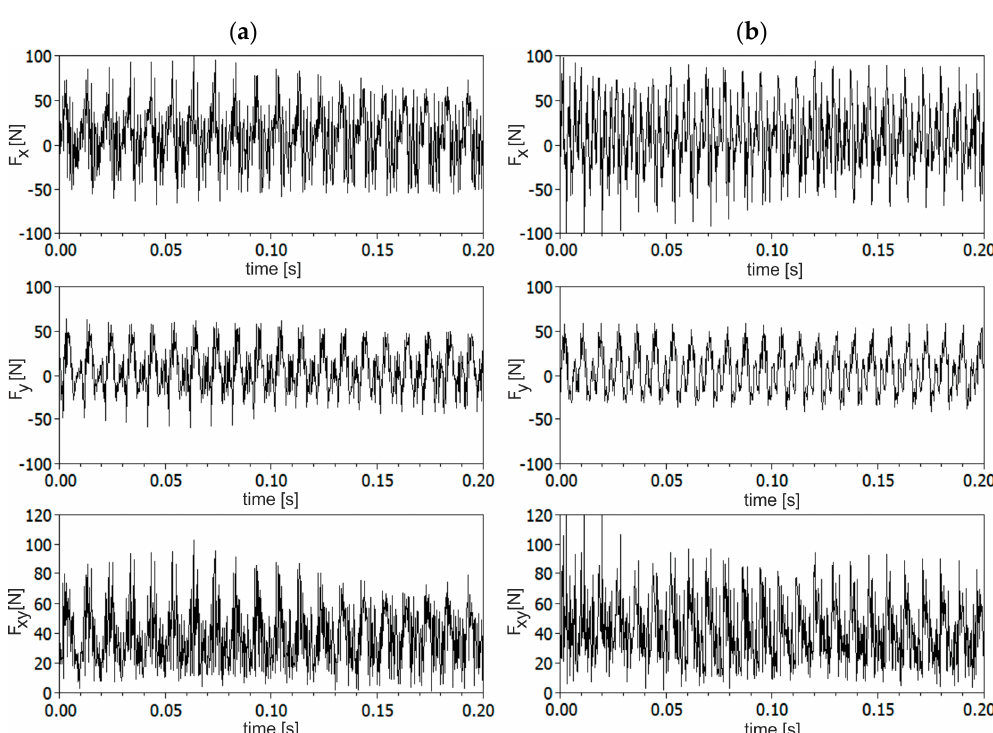
Figure 4. Changes of F x , F y components and resultant cutting force F xy acting on the end mill cutter for: ( a ) stable ( a p = 0.5 mm, n = 6000 rpm) and ( b ) unstable cutting ( a p = 0.5 mm, n = 7000 rpm).